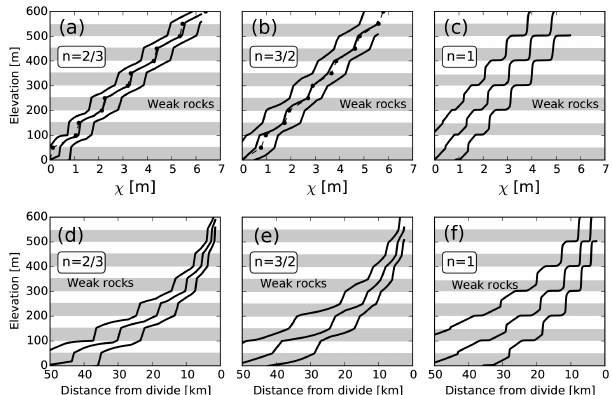
Figure 4. Channel profiles in subhorizontally layered rocks with high uplift (2.5mmyr − 1 ). (a–c) Channel profiles in χ -elevation space for cases where n = 2 / 3 (a) , n = 3 / 2 (b) , and n = 1 (c) . (d– f) Channel profiles as a function of distance from divide. Each panel contains three time snapshots of the profile with uplift subtracted from elevation so that the profiles evolve from left to right. Grey bands represent the weak rock layers. The dashed lines (a, b) show the profiles predicted by the continuity steady-state theory (Eqs. 5 and 8), with filled circles depicting predicted crossing points of the contacts. Channel profiles obtain a steady-state shape except near base level, where a constant rate of base-level fall is imposed. For n (cid:54)= 1 the equilibrium profile steepness (slope in χ space) has a one- to-one relationship with rock erodibility, with steeper channels in weaker rock if n < 1. For n = 1 there is no unique relationship be- tween erodibility and steepness, as continuity cannot be maintained along the entire